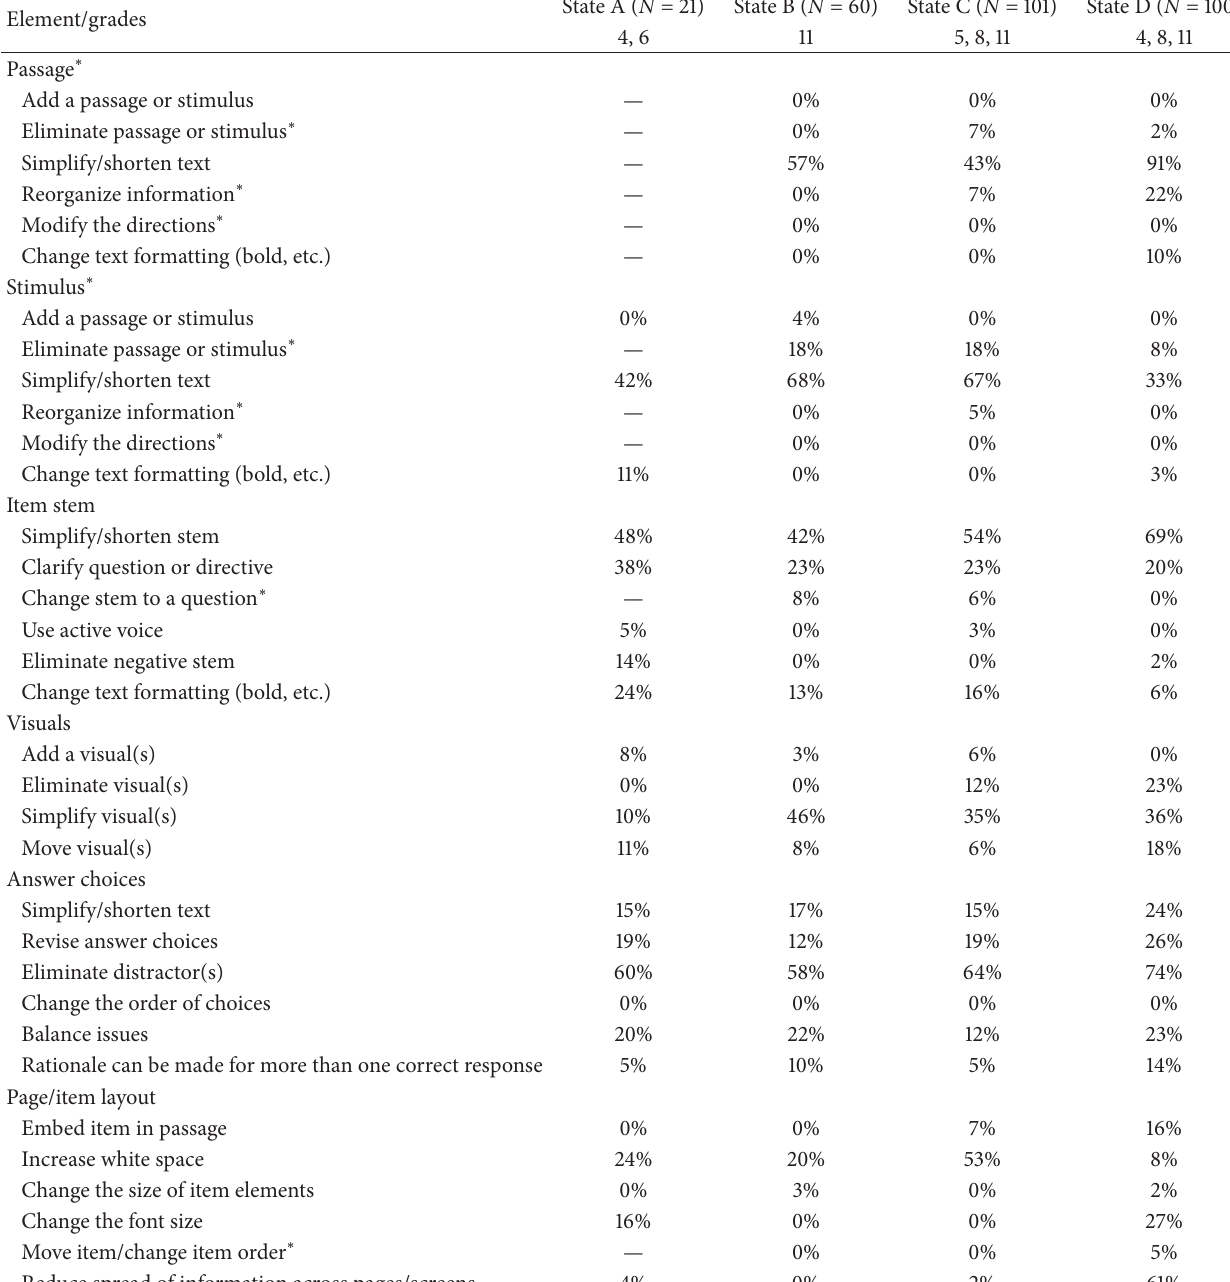
Table 5: Suggested modifications for science items, percentages by